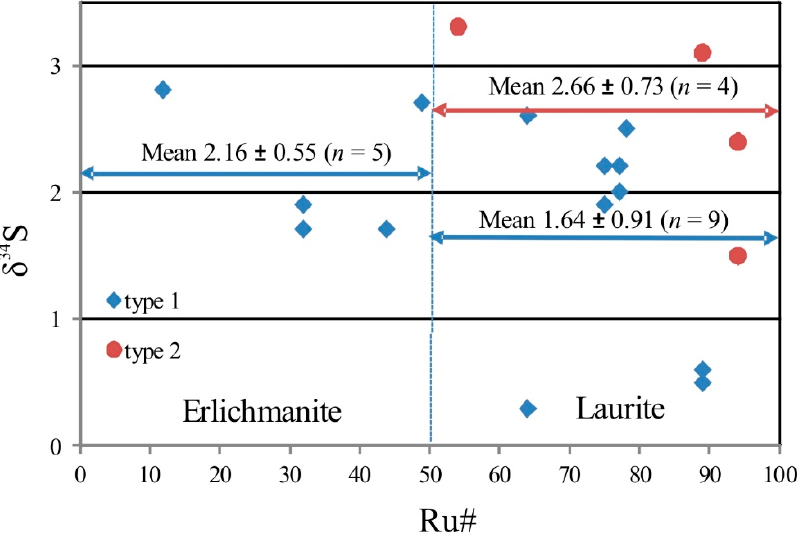
Figure 10. Sulfur isotope data for Ru-Os sulfides of type 1 and 2 within primary PGM assemblage from the Verkh-Neivinsk massif.